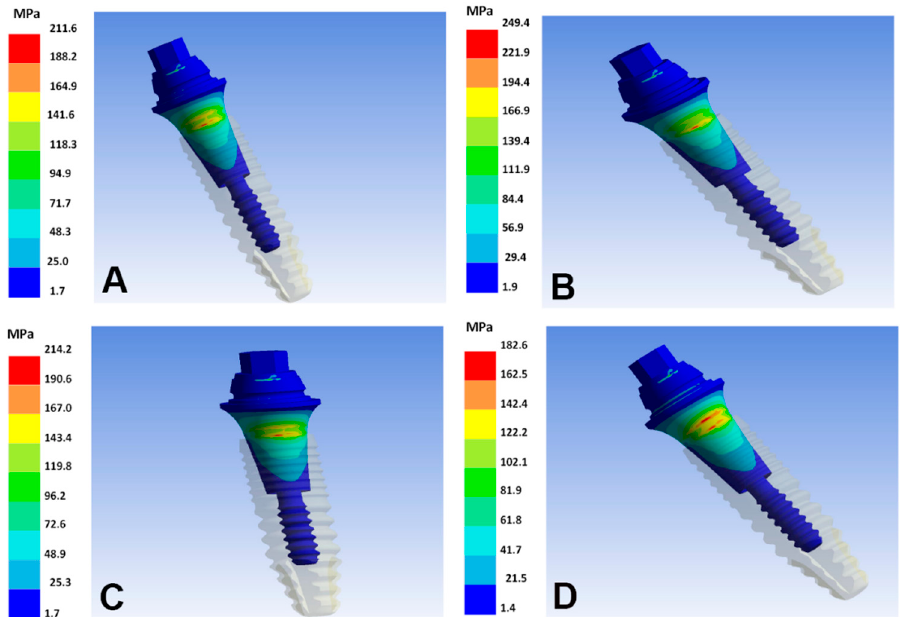
Figure 5. von Mises equivalent stresses in the abutment surface of the different alloys. ( A ) Ti–6Al–4V; ( B ) Ti–26.88Fe–4Ta; ( C ) Ti–15Zr; ( D ) Ti–13Nb–13Zr.